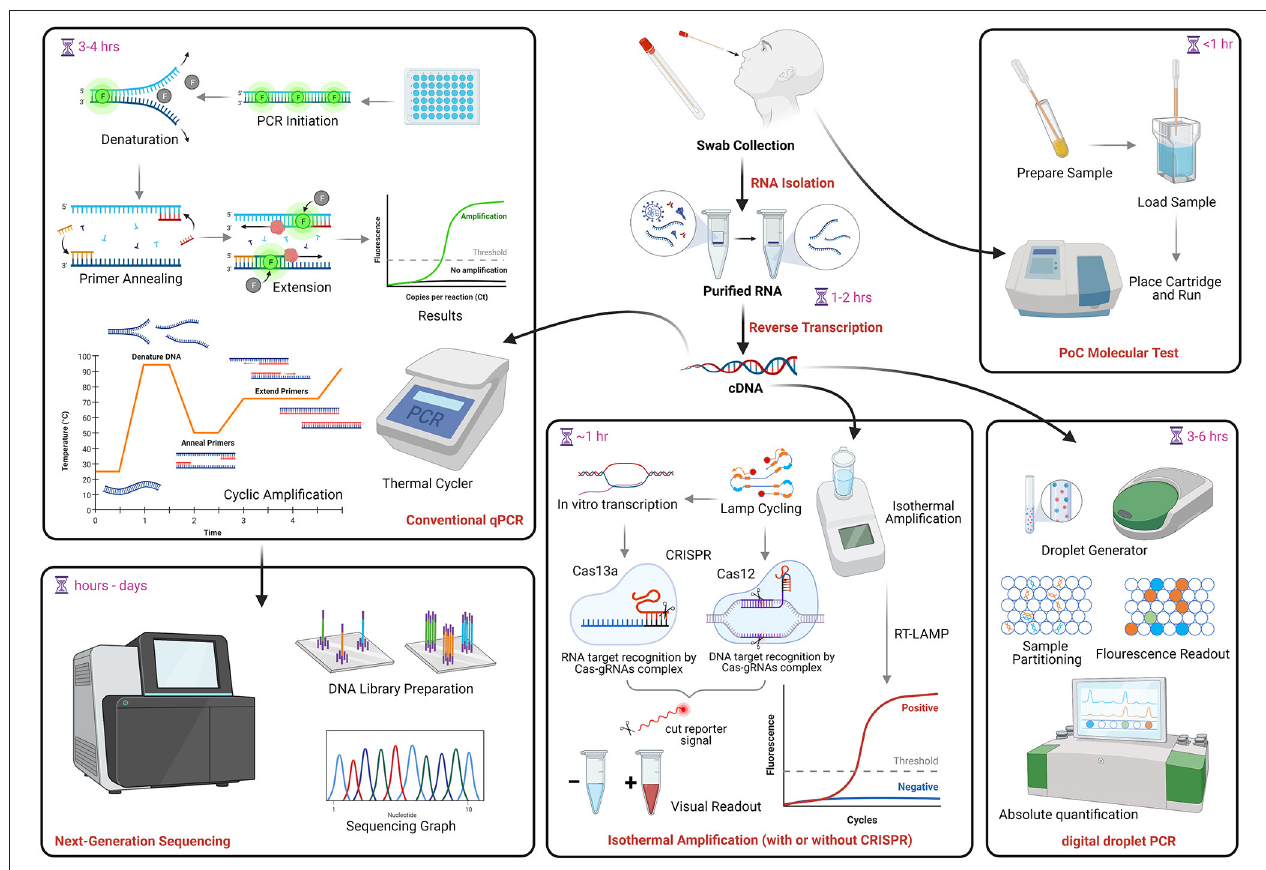
FIGURE 1 | COVID-19 molecular testing. NAAT begins with RNA extraction followed by reverse transcription into complementary DNA (cDNA). The same cDNA can be used for conventional qPCR, RT-LAMP, which can also be coupled with CRISPR technology, and droplet digital PCR. PoC assays (uppermost right) use direct specimen and cartridge-based tests to produce rapid results. The PCR amplification product may be used to generate viral genome sequences (lowermost left). NAAT, nucleic acid amplification tests; qPCR, quantitative polymerase chain reaction; PoC, point of care; LAMP, Loop-mediated isothermal amplification; CRISPR, clustered regularly interspaced short palindromic repeats. Image created in